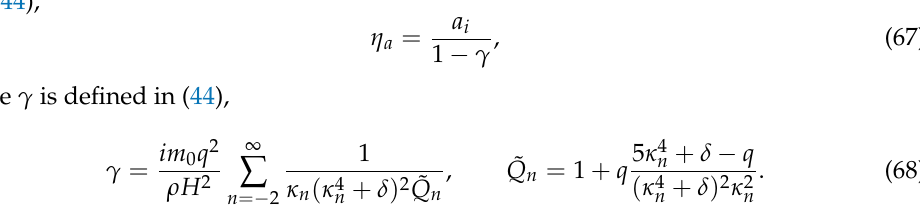
√ q for different dimensionless length of the rigid plate